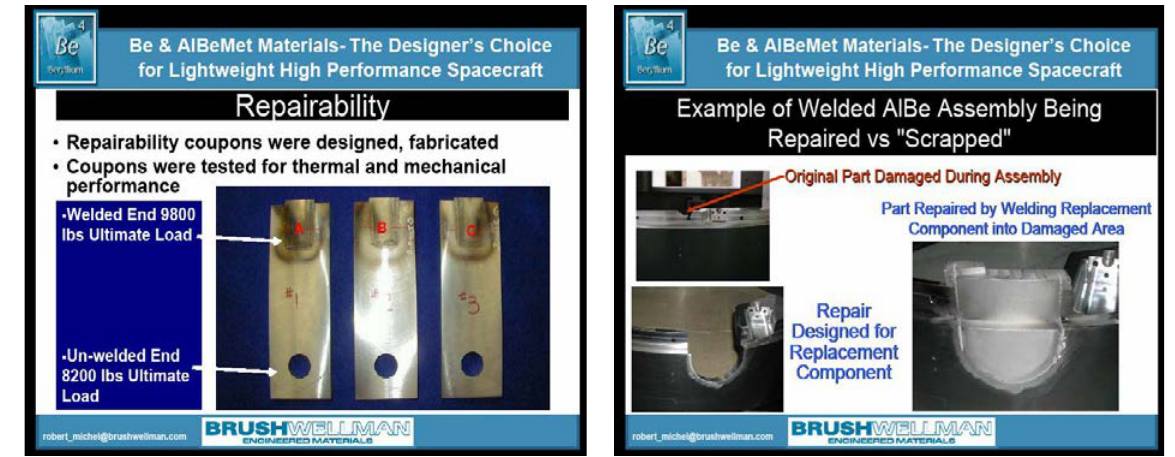
Figure 11. The EBW repaired sections of Be-Al alloy [62] Reprinted/adapted with permission from Ref. [62] Copyright 2008, SPIE.